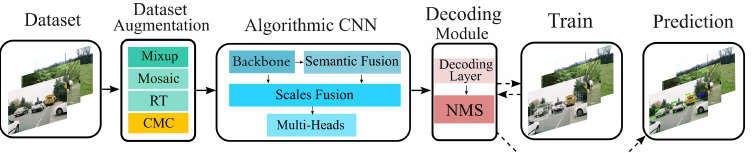
Figure 4. The pipeline of the proposed algorithm. The CMC represents Consistent Mixed Cropping. NMS represents non-maximum suppression. The RT represents Random